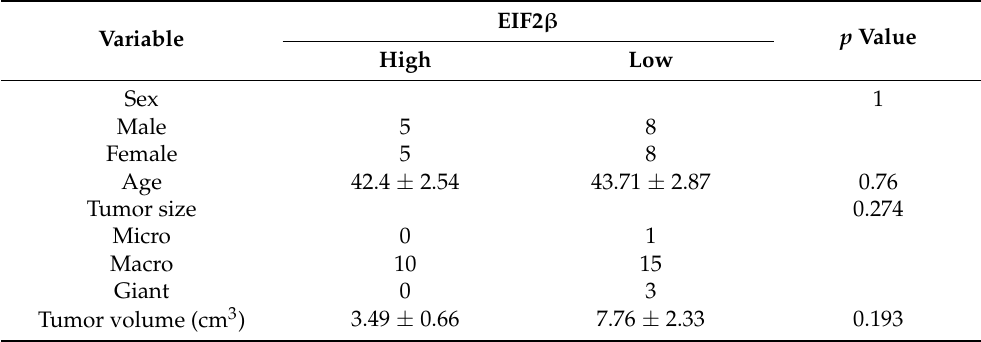
Table 2. Clinically pathological features of patients with somatotroph